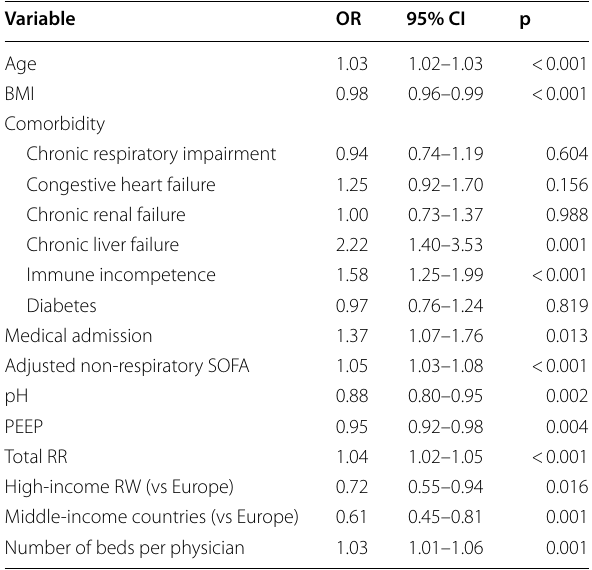
Table 5 Multivariate logistic regression model of factors associated with limitation of life-sustaining